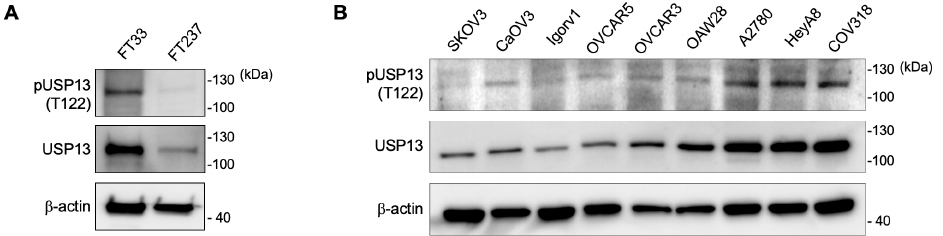
Figure 3 . Endogenous USP13 is phosphorylated at Thr122 in various human ovarian cancer cells. Total USP13 and pUSP13 (T122) were detected by western blotting. ( A ) USP13 was phosphorylated at T122 in human fallopian tube secretory epithelial cells. ( B ) Protein lysates were prepared in 9 human ovarian cancer cells. pUSP13 (T122) was detected in all ovarian cancer cells, and the phosphorylation level at Thr122 increased as the total USP13.